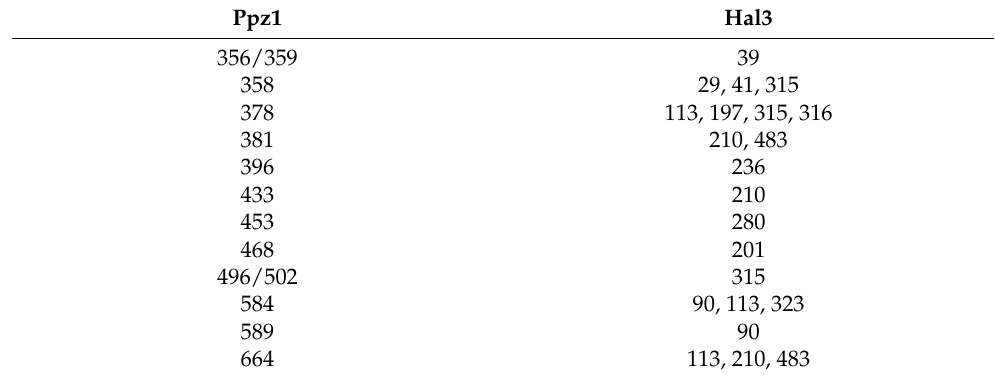
Figure 6. Chemical cross-link between the catalytic domain of Ppz1 and Hal3. ( A ) The catalytic domain of Ppz1 tagged with a 6xHis sequence at the N-terminus (6xHisPpz1 Cter ) was co-expressed with full-length Hal3. Upon metal-affinity purification and change of the buffer by filtration, samples were electrophoresed and stained with Coomassie blue. ( B ) Samples of the Ppz1 Cter plus Hal3 mixture were incubated with BS3 (10 × excess) as described and electrophoresed in 6% polyacrylamide gels prior staining. Arrows indicate the position of the monomeric proteins and the asterisk (*) the high molecular mass complex excised for MS determination. “Stck” denotes the position of the stacking gel (not removed prior imaging). ( C ) Bidimensional map showing the relative positions of cross-linked K in Ppz1 Cter and Hal3. Relevant K residues discussed in the text are highlighted in color. ( D ) Mapping of K584 and K589 in a surface model of Ppz1. Residues that differ between Ppz1 and Glc7 are in red, and catalytic residues are in yellow. Purple residues correspond to amino acids previously identified as relevant for Ppz1 inhibition [39]. See main text for discussion. Table 2. Relevant lysine residues in the catalytic domain of ScPpz1 that cross-link with Hal3